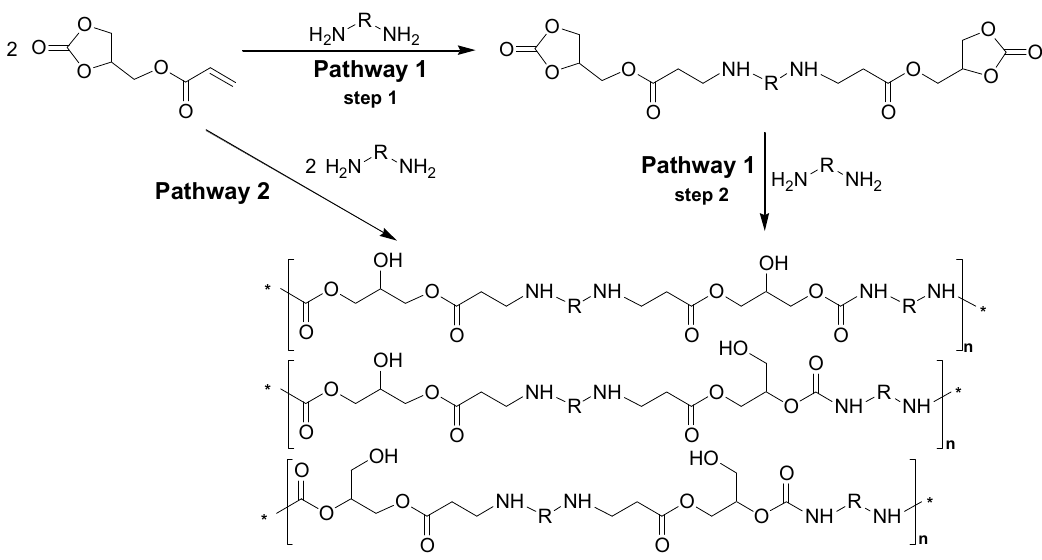
Figure 1. Synthesis of a glycerol amino ethylene ester PHUs (R = C 2 H 4 , C 6 H 12 , C 6 H 15 N 2 ).